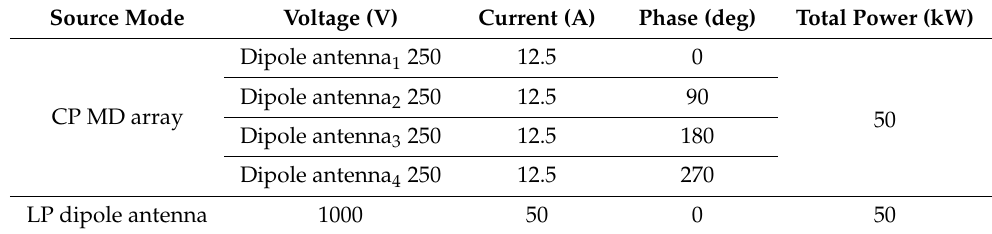
Table 1. Excitation of two source modes with the same TP.